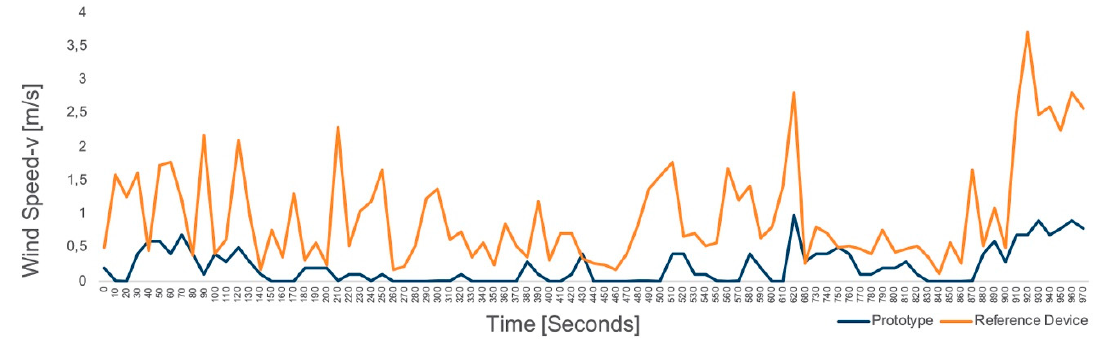
Figure 16. Validation graph for wind speed.